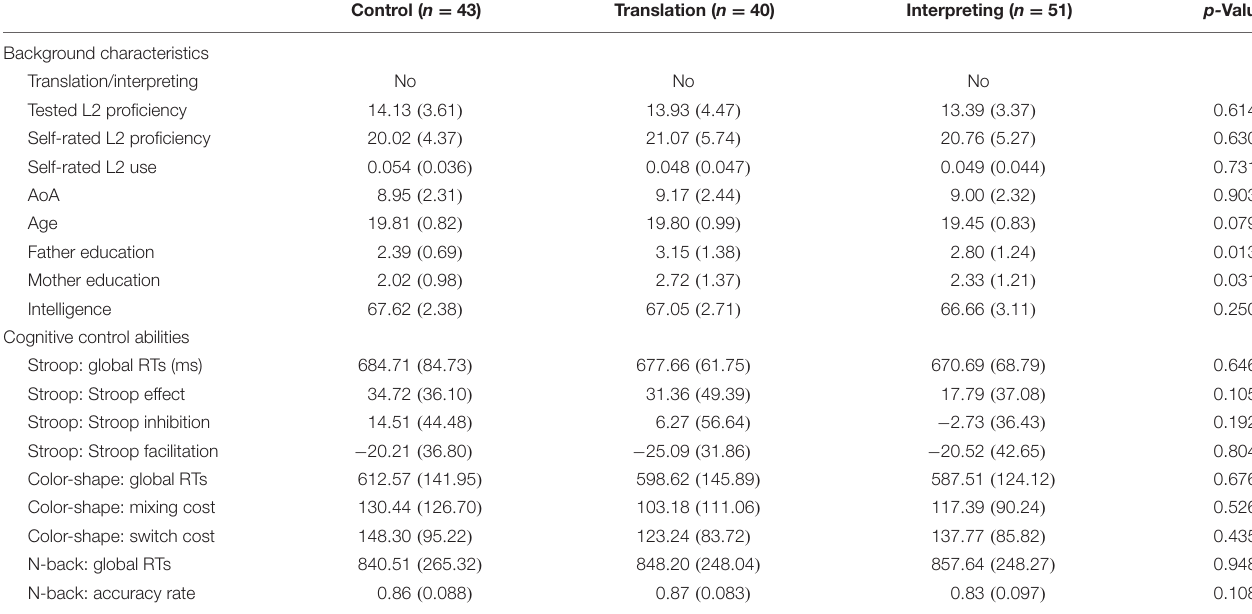
TABLE 2 | Pre-test group means (with SD) and comparisons ( p- value) of participants’ background characteristics and task performances in the pre-test before group match.